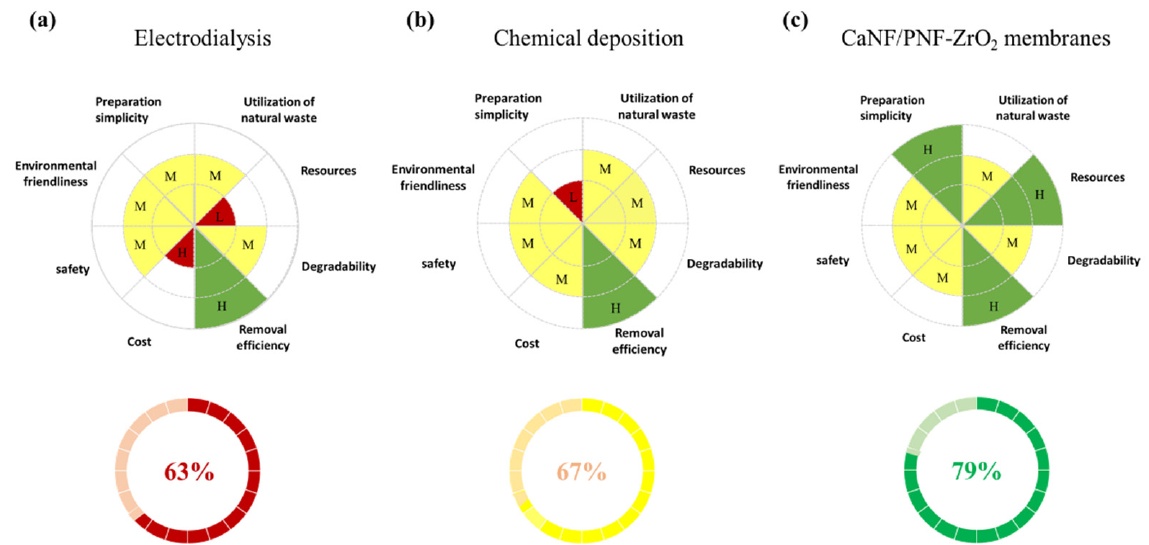
Figure 8. Sustainability analysis of inorganic-organic hybrid membranes by comparing with two adsorption methods: ( a ) Electrodialysis method [44], ( b ) Chemical deposition method [45], and ( c ) hybrid membrane filtration.